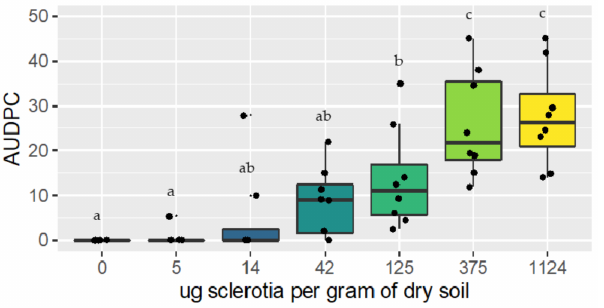
Figure 5. Results of the artificial inoculation trials performed under controlled conditions for R. solani AG 1-IB. Each boxplot shows the distribution of the combined results of the two experiments, with different letters indicating a significant difference between treatments according to an LSD